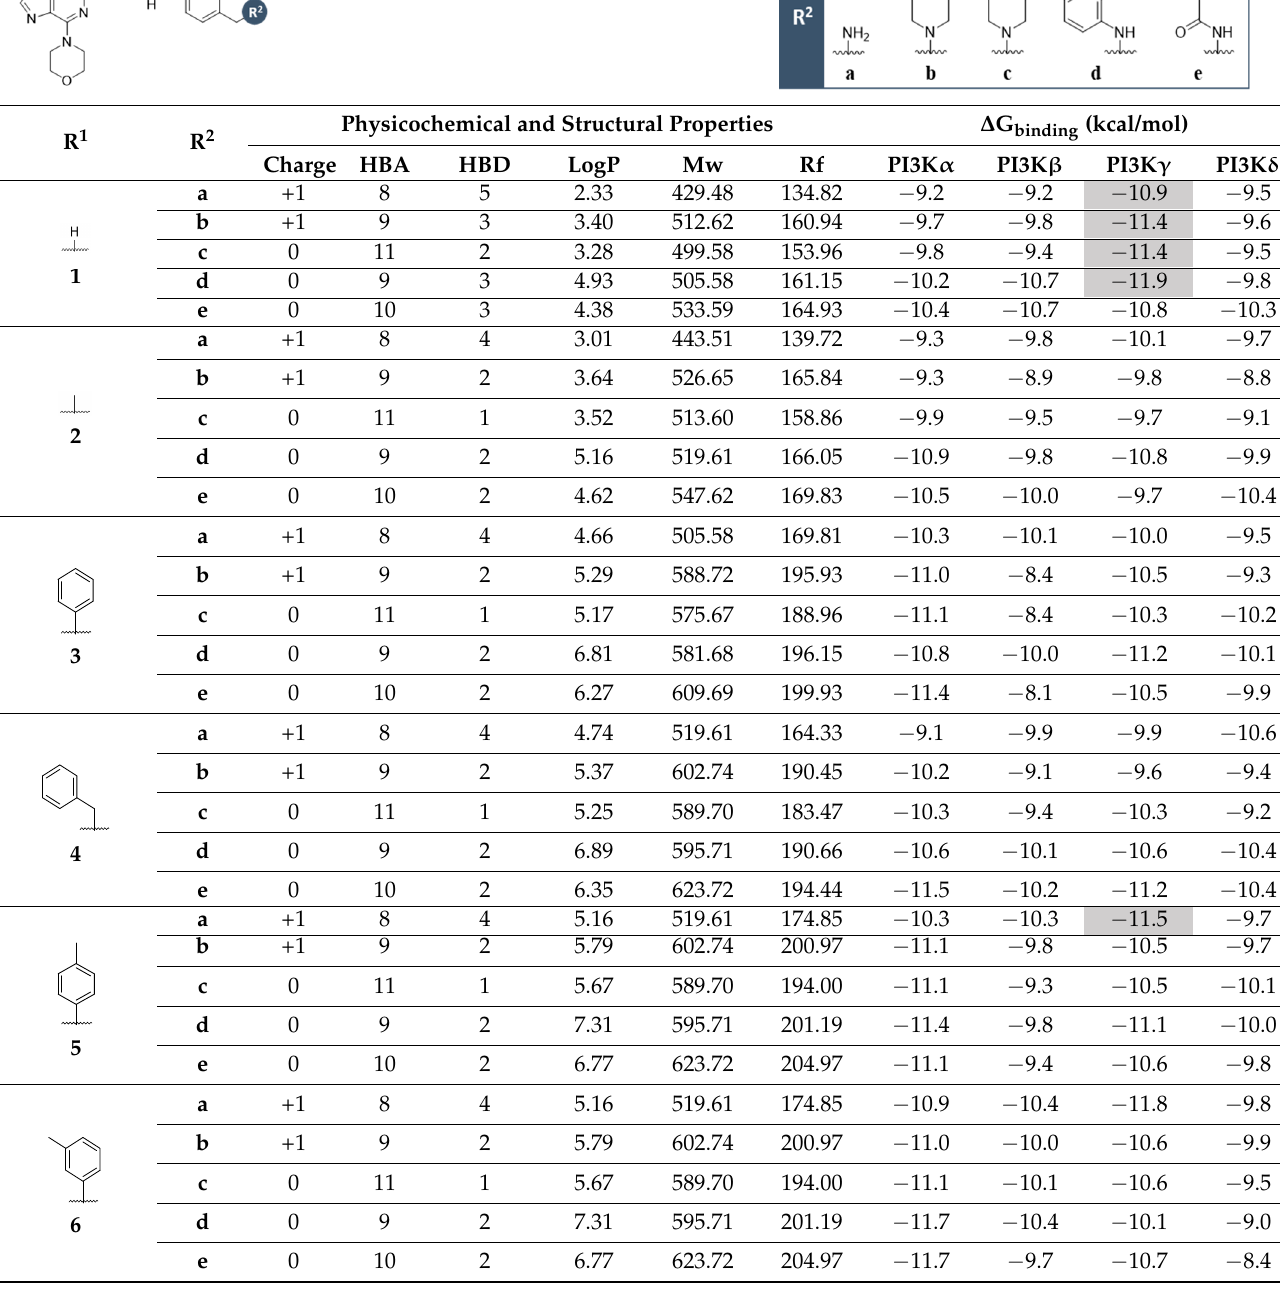
Table 1. Description of the physicochemical and structural properties of the ligands under study and their affinity ( Δ G binding ) to the 4 Class 1 PI3K isoforms. Selective inhibitors are highlighted in the grey scale.